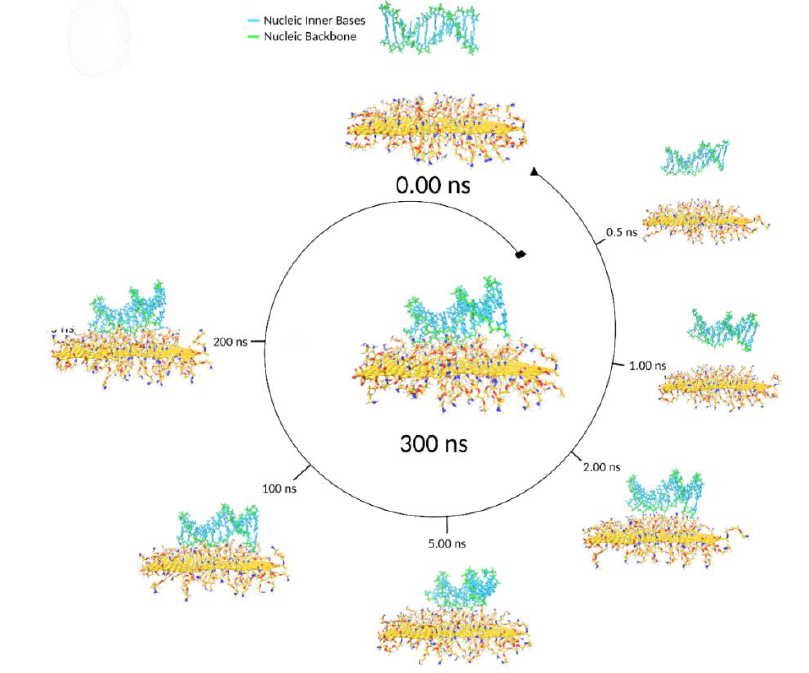
Figure 11. Trajectory snapshots ranging from 0 to 300 ns of dsDNA and rGO-PEG-NH2 in the presence of both Mg 2+ and Cl − atoms (ions not shown).